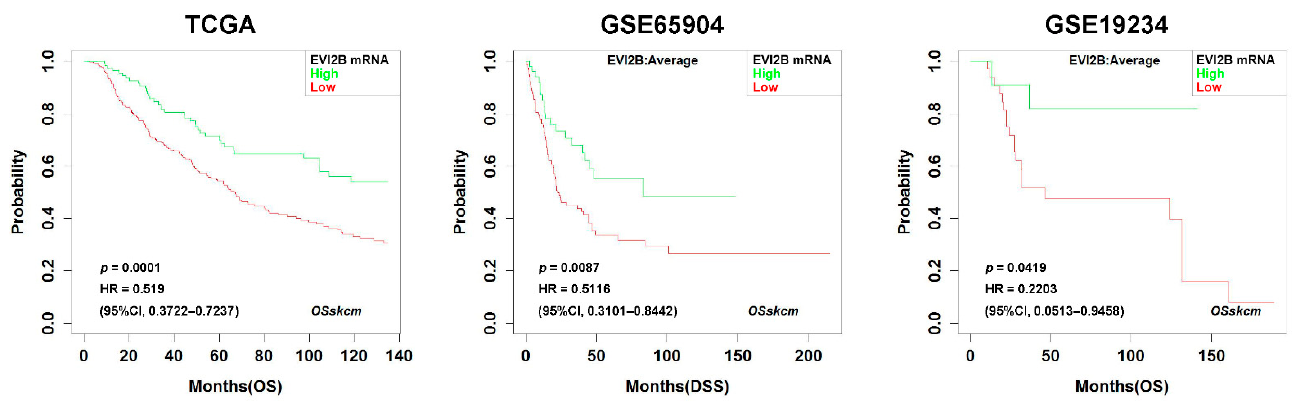
Figure 1. Kaplan–Meier survival curves in EVI2B high vs. EVI2B low patients with metastatic melanoma in TCGA, GSE65904, and GSE19234. The outcomes are overall survival (OS) ( left and right panels ) and disease-free survival (DSS) ( middle panel ).